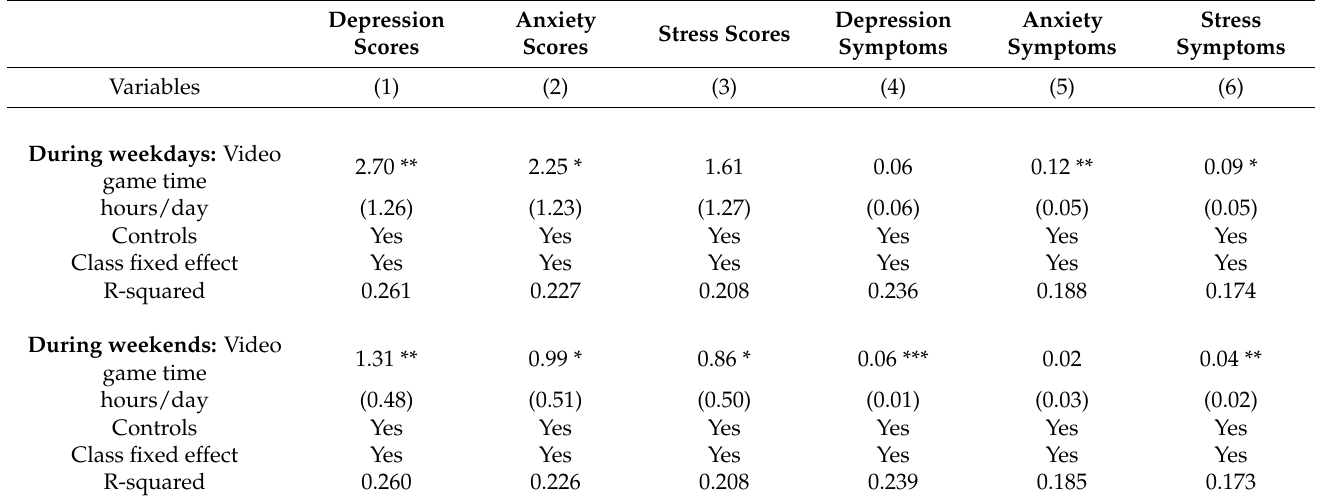
Table A2. OLS regression of daily video game time on adolescent mental health during school and weekend,